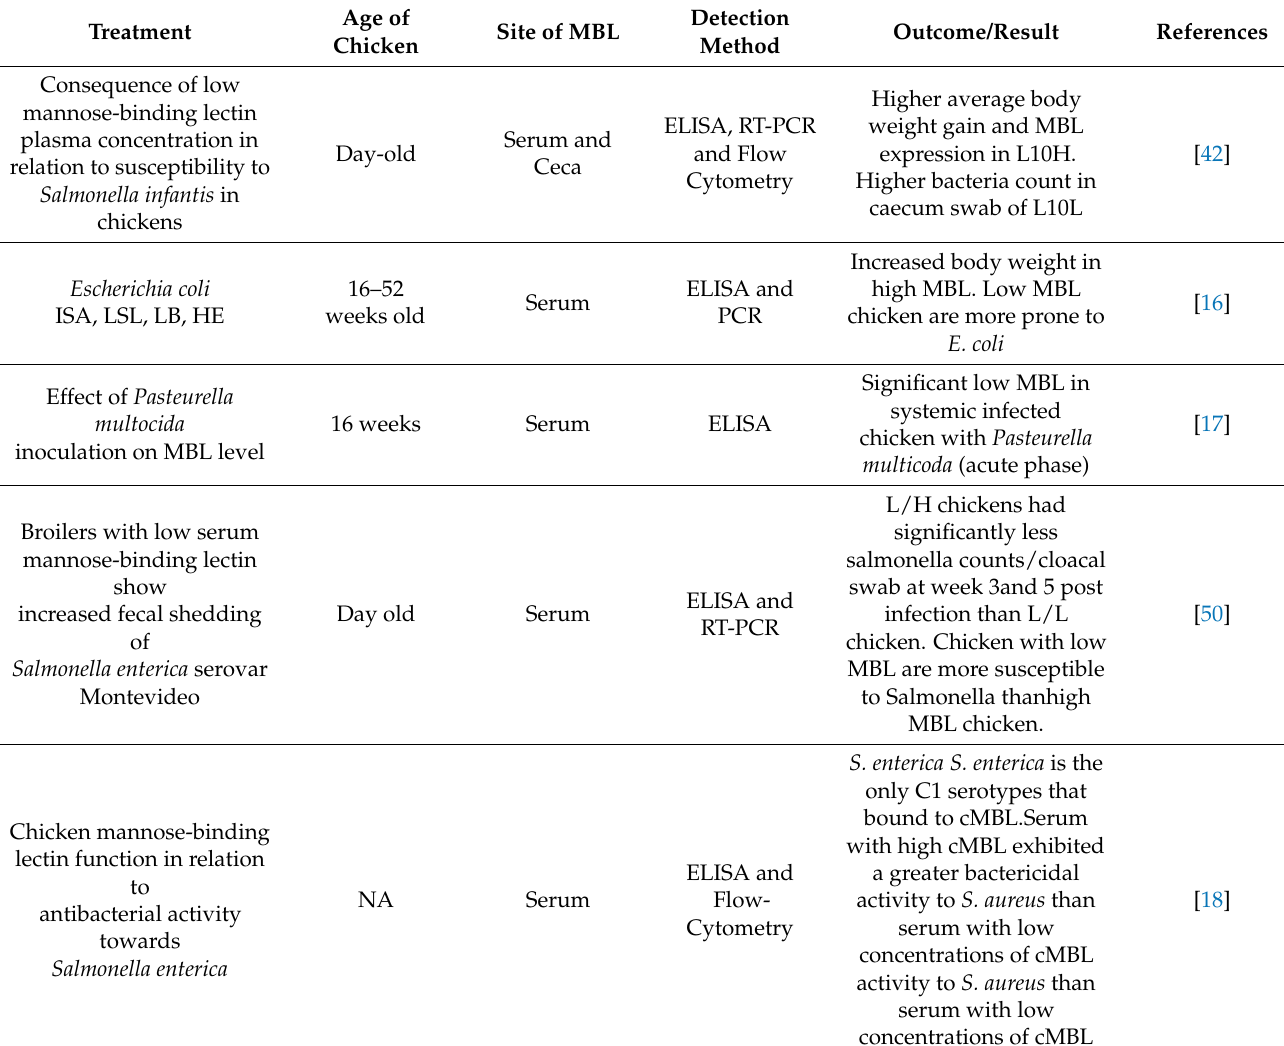
Table 2. The impact of cMBL on bacterial disease and growth rate in